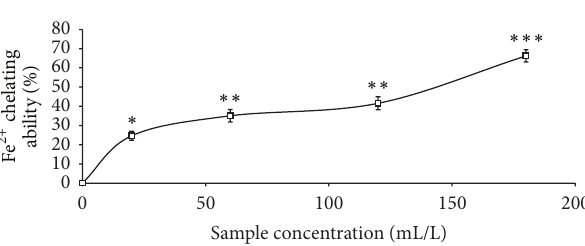
Figure 3: Fe 2+ chelating ability of essential oils from black pepper. Values represent means ± standard deviation of triplicate readings.